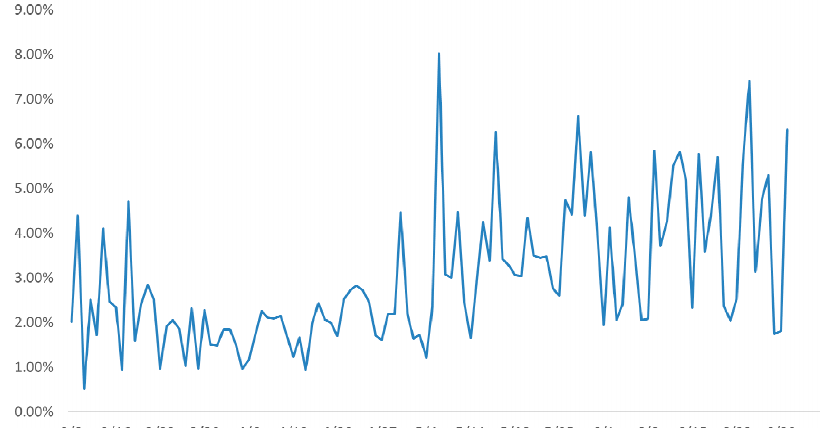
Figure 3. The plot of the recovery rate of diagnosed patients.